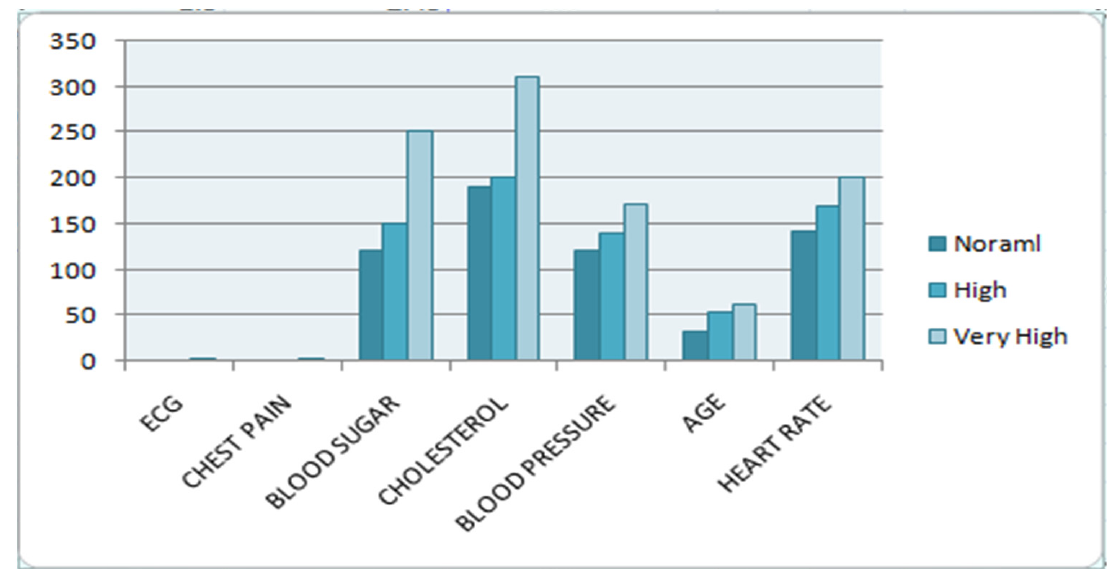
Figure 9. The levels of heart disease output.